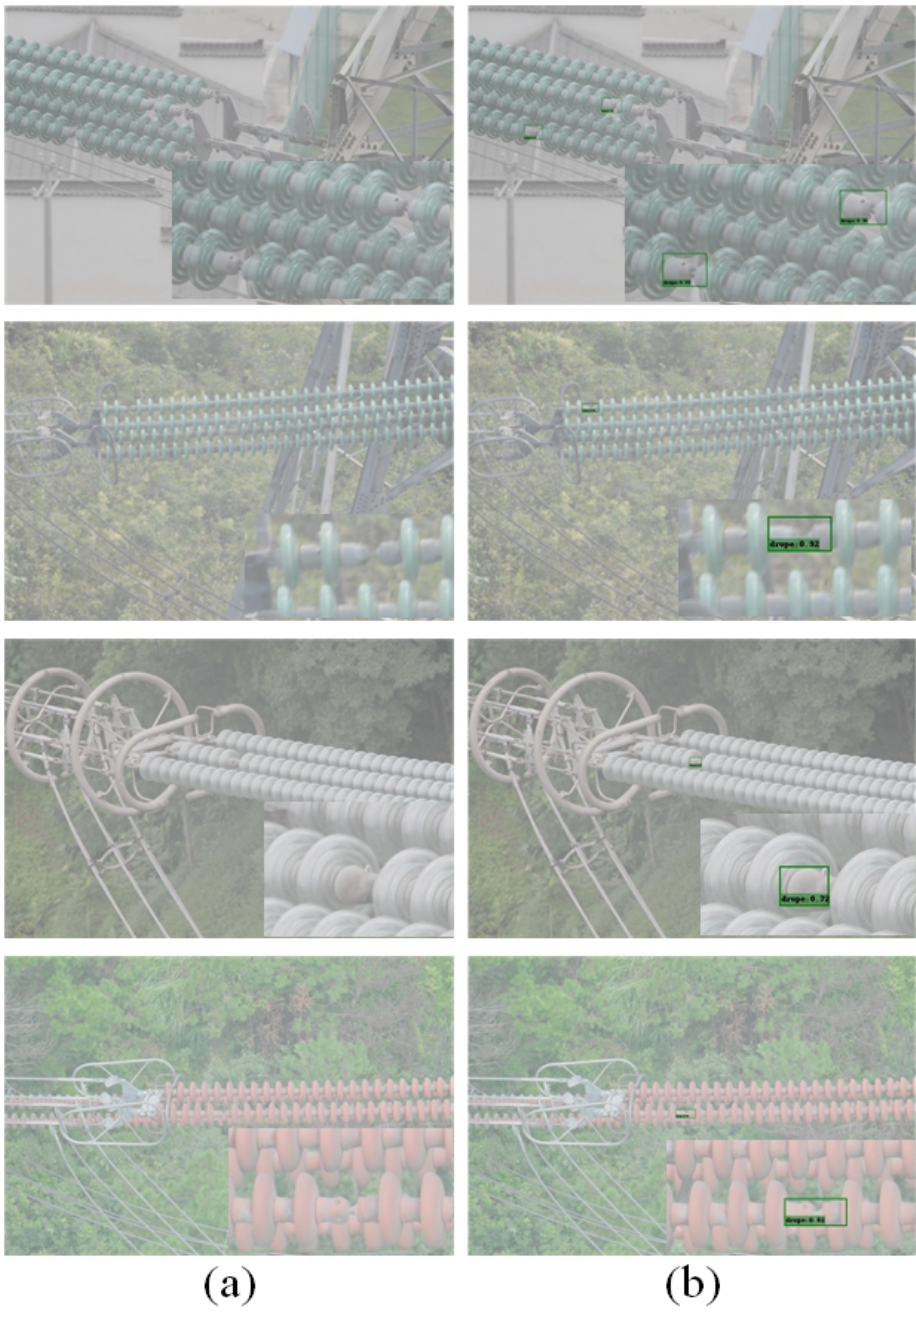
Figure 8. Visualization of SSD and FA-SSD. ( a ) SSD. ( b )